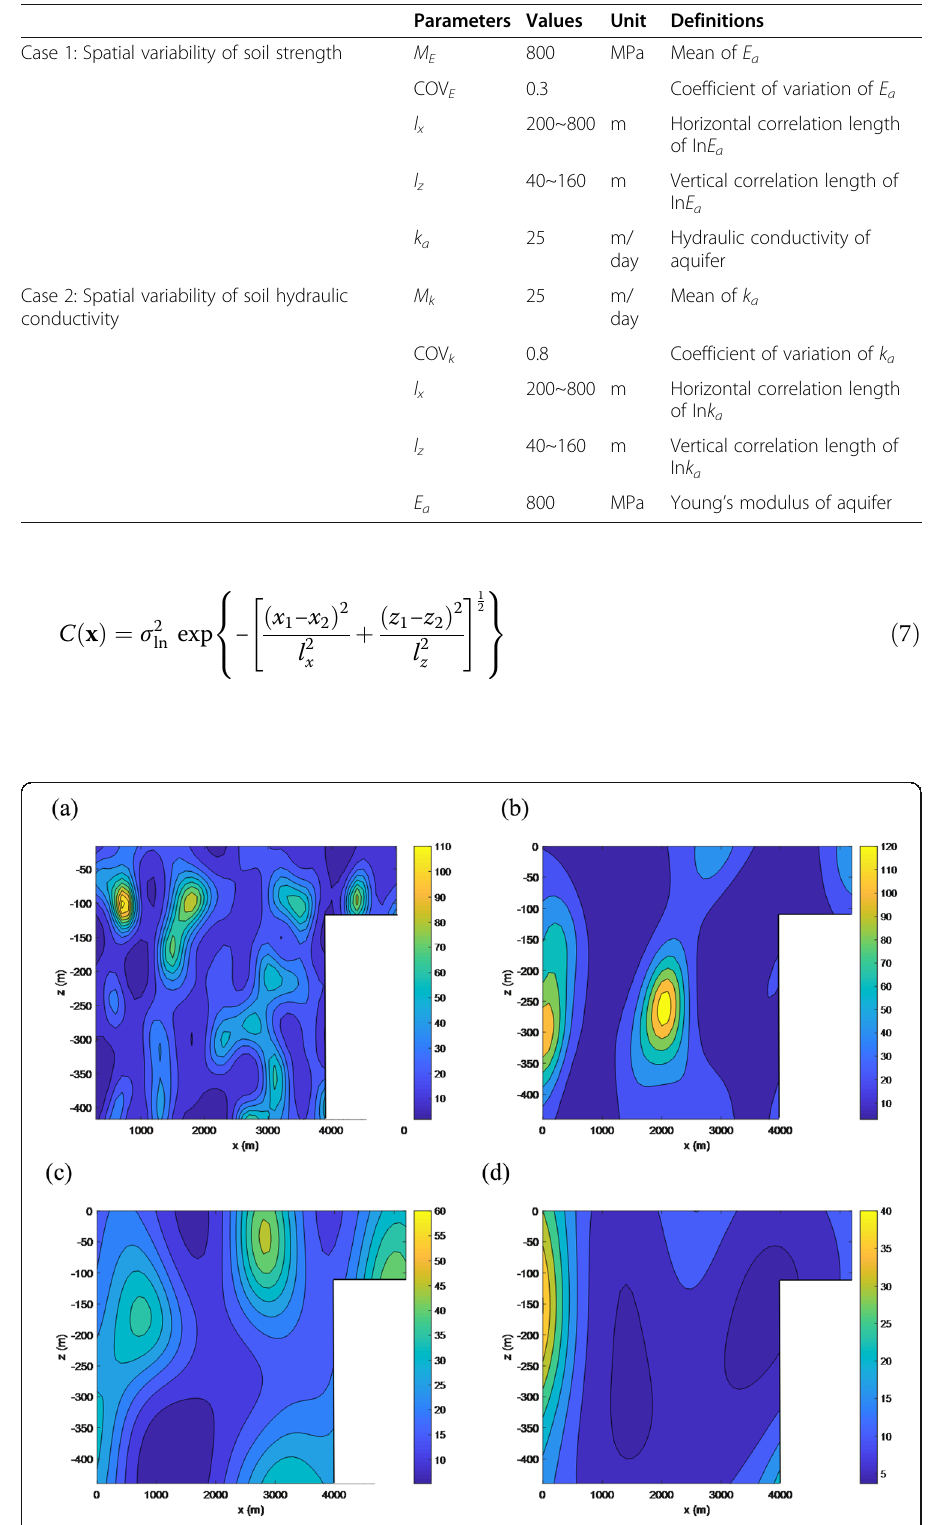
Fig. 2 One realization of lognormal random fields (mean = 25, COV = 0.8). a l x = 200 m, l z = 40 m. b l x = 400 m, l z = 80 m. c l x = 600 m, l z = 120 m. d l x = 800 m, l z = 160